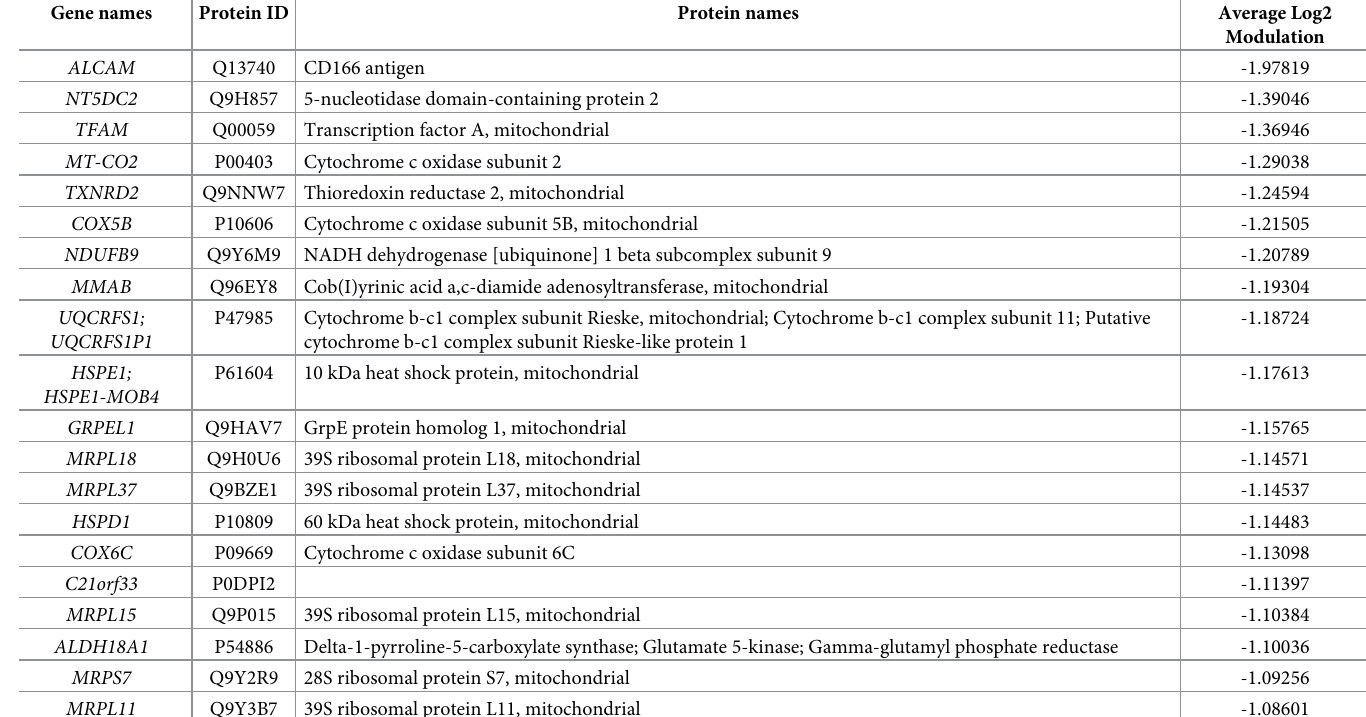
Table 2. Twenty most modulated autophagosome-associated proteins in Leishmania -infected compared to rapamycin-treated